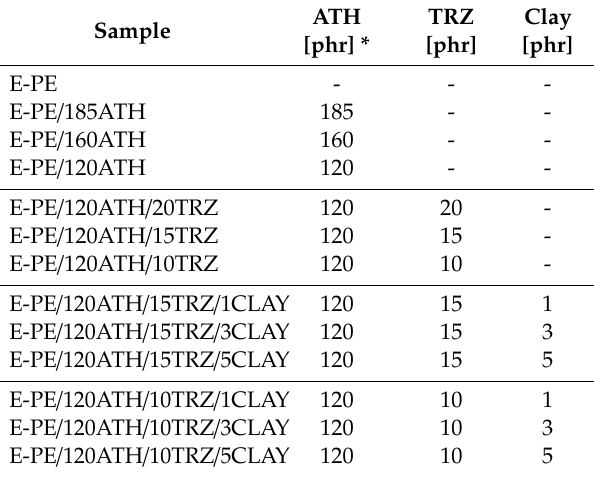
Table 1. Compositions of investigated composites.